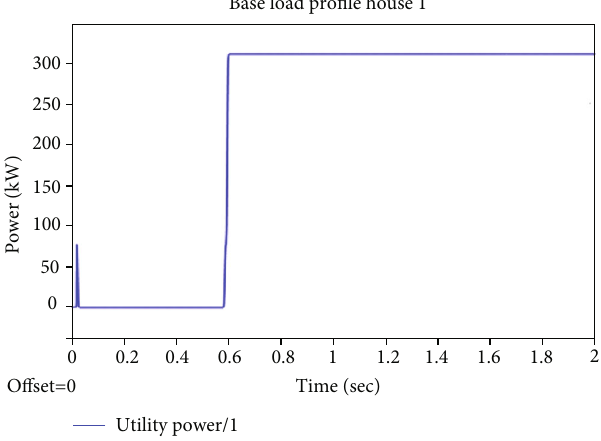
Figure 31: House one base load pro fi